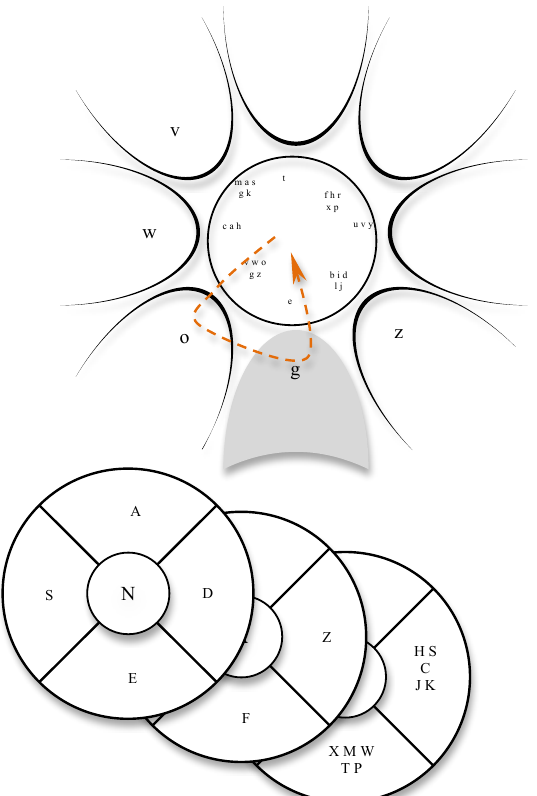
Figure 4: 1) Example of a gesture in quickwriting adapted from (Bee & André, 2008). 2) The modified pEYE interface with third predictive expansion. (Urbina & Huckauf, 2010)